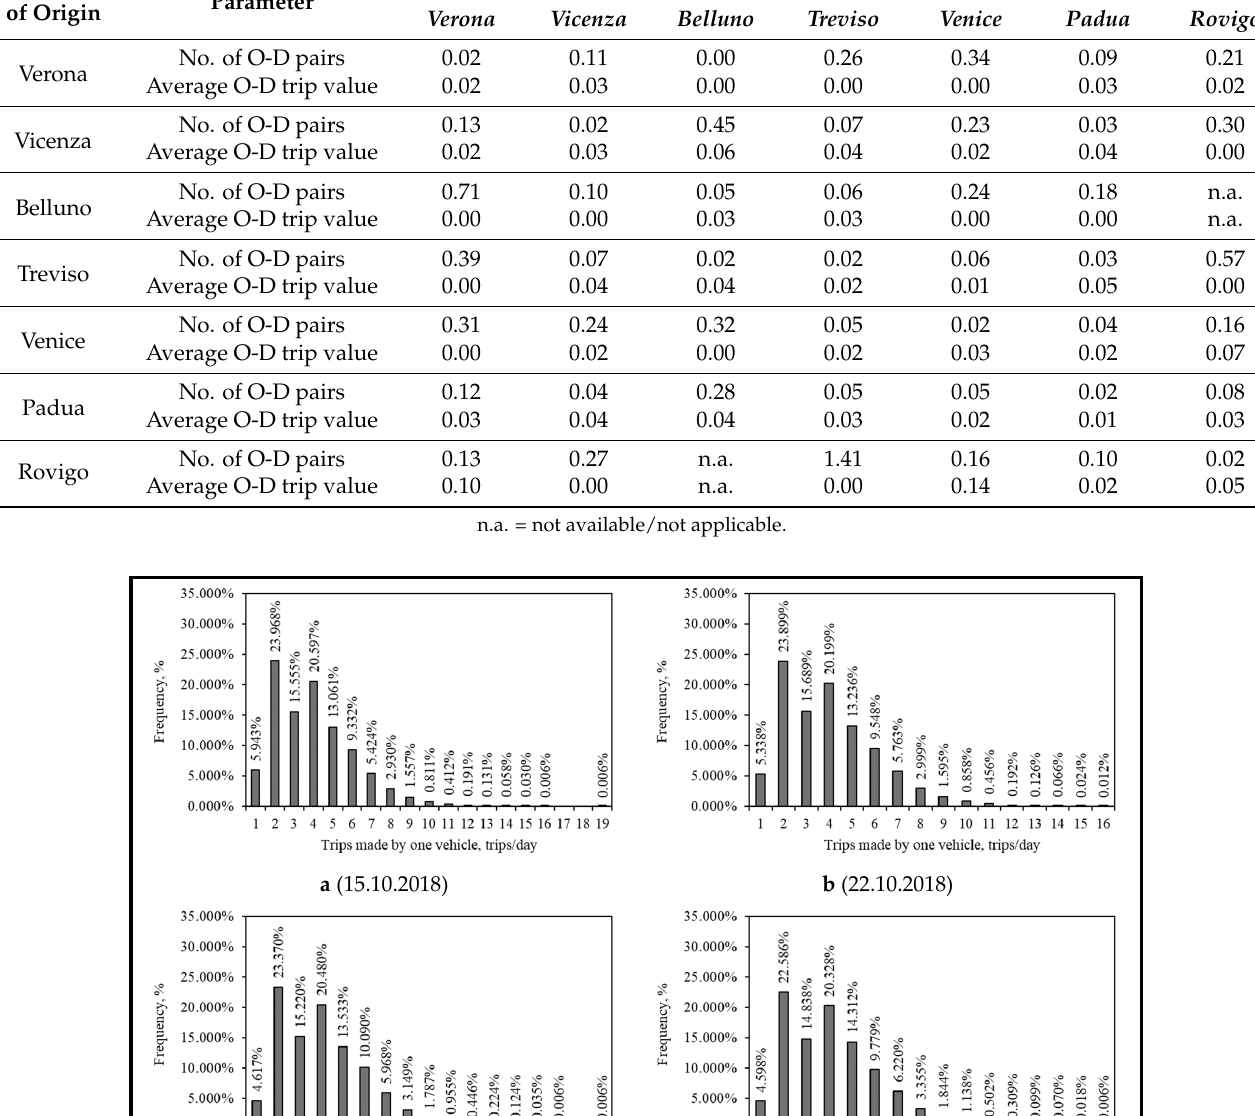
Table 5. Coefficients of variation on O-D pairs of trips for the five survey days.